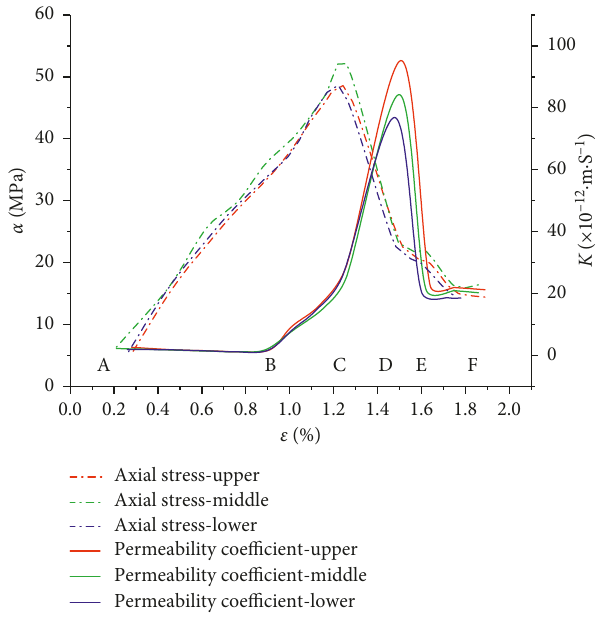
Figure 5: The changes for the rock strength and permeability coefficient with the strain of the collapsed